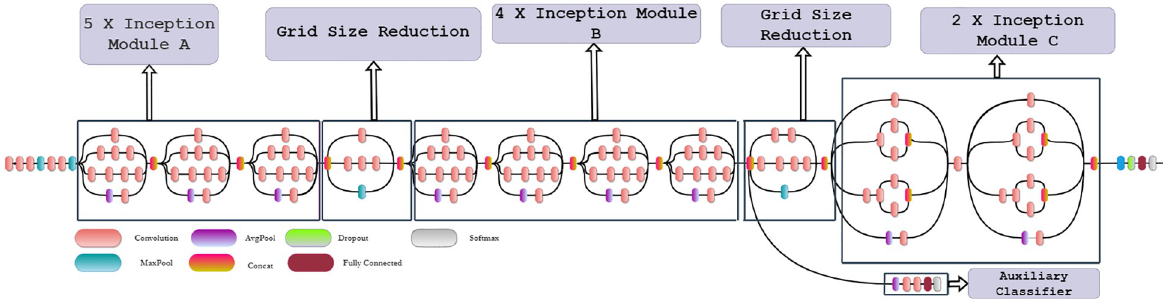
Fig 2. Architecture of inception V3. Modified from